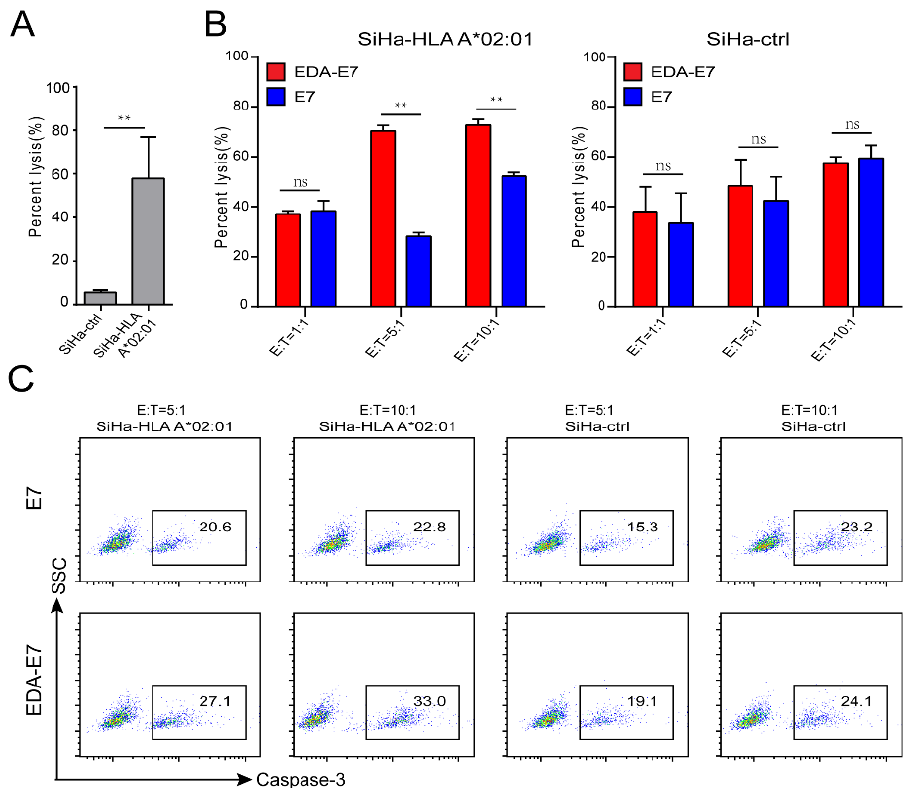
Figure 7. Targeted killing of HPV infected SiHa cells by the activated T cells. TCRT specific lysis assay confirmed the function of HLA-A*02:01 in SiHa ( A ); luciferase lysis assay for T cell target killing of wild type and HLA-A*02:01 expressing SiHa cells at 12 h with different E:T ratios ( B ); cleaved caspase3 flow cytometry for SiHa cells after co-culture T cells ( C ), ** p < 0.01, ns: no signifi- cance.